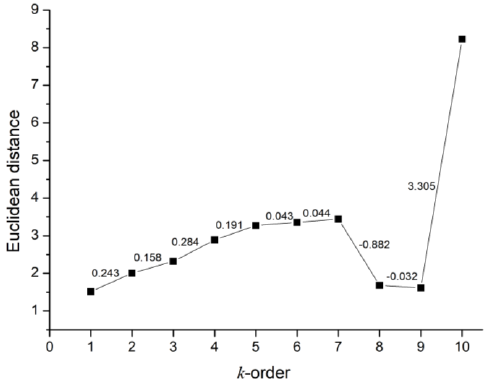
Figure 5. Influence between roads in the case of different k -order.